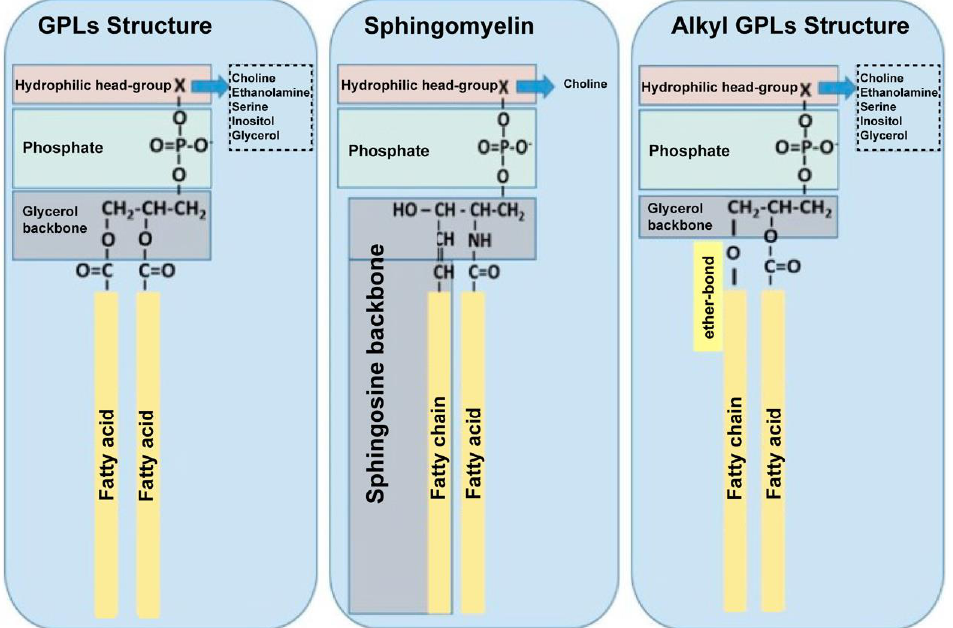
Figure 2. Representation of common phospholipid structures: Glycerophospholipids (GPLs); an example of sphingosine-backbone phospholipid (SPLs), Sphingomyelin; and Alkyl-GPLs, which contain a fatty chain linked with an ether-bond at the sn -1 position of the glycerol backbone [71].